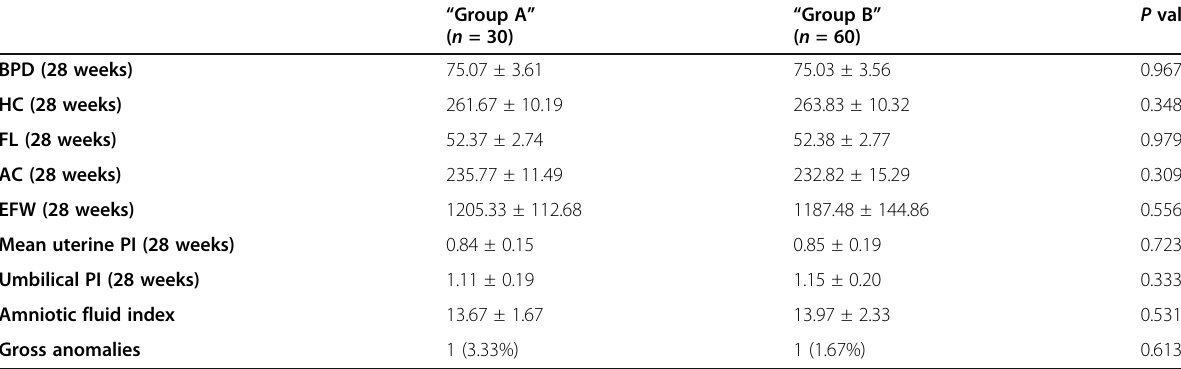
Table 3 Fetal assessment at 28 weeks of gestation in both groups